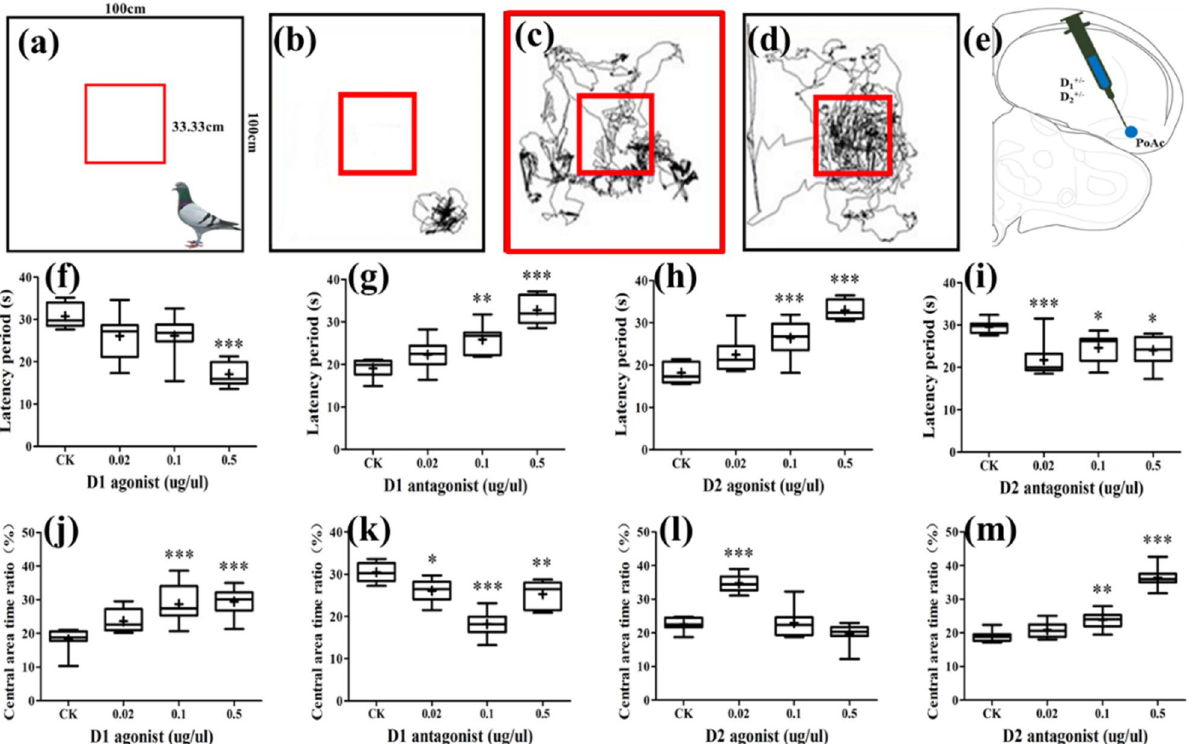
Figure 5. Effects of different drugs on forward behavior. ( a ) Schematic of personalized screening ( N = 25 ). ( b – d ) Locomotion trajectory of different pigeons ( b : N = 8, c : N = 8, d : N = 9 ). ( e ) Schematic coronal view of in vivo injections of different drugs into PoAc at A 5.0. ( f – i ) Effects of D1 and D2 receptor agonists and antagonists on the latency period of pigeons for entering the central area ( N = 8 ). ( j – m ) Effects of D1 and D2 receptor agonists and antagonists on the residence time of pigeons in the central area ( N = 8 ). Data of all groups are presented as mean ± SE. PoAc compact division of posterior pallial amygdala; SE standard error of